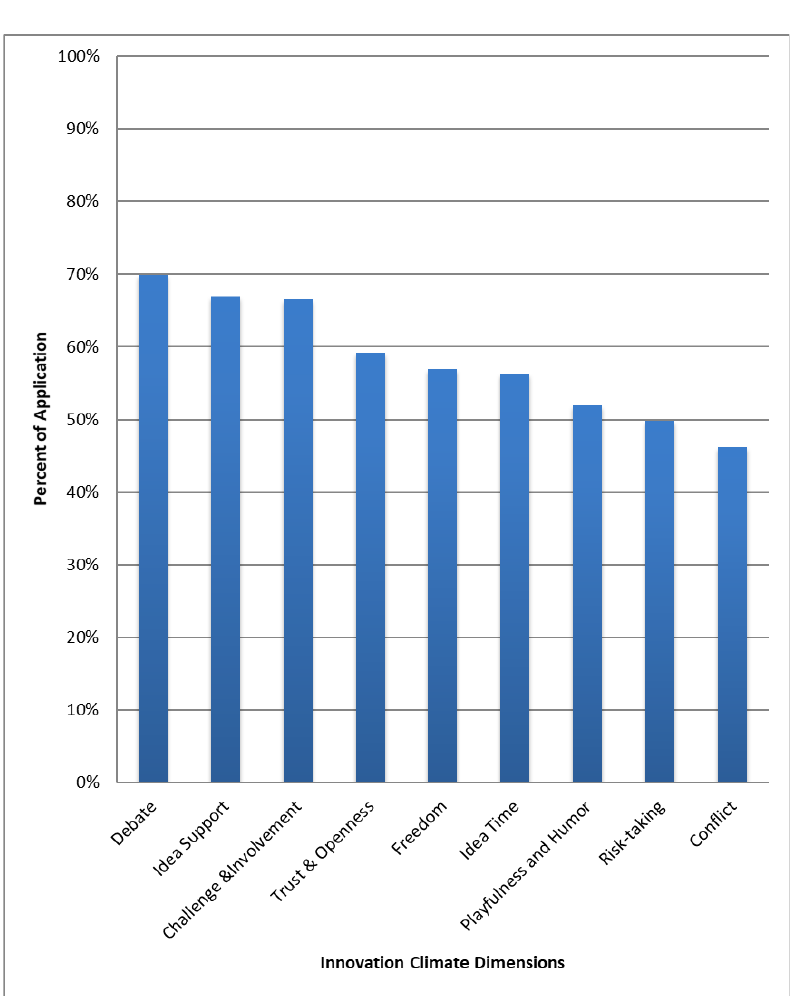
Fig. 1. Application levels of the technological innovation climate